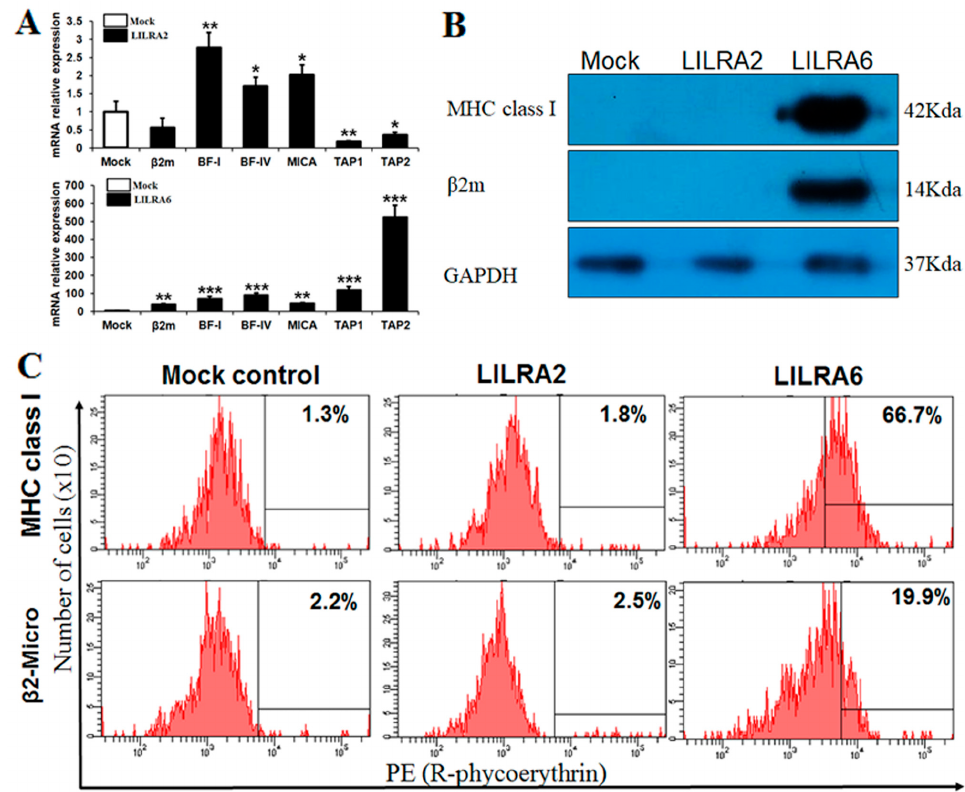
Figure 3. Chicken LILRA2 and LILRA6 binding with MHC class I and β 2m. ( A ) qRT-PCR for MHC class I family and related genes in LILRA2 and LILRA6 transfected HD11 cells; ( B ) Western blot for LILRA2 and LILRA6 transfected HD11 cells immunoprecipitated with the MHC class I, β 2m mAb, GAPDH antibody and then separated by SDS-PAGE and immunoblotted with secondary antibody; ( C ) FACS analysis of LILRA2 and LILRA6 binding with MHC class I and β 2m mAb in HD11 cells. Data are presented as the mean ± SEM of three independent experiments: * p < 0.05, ** p < 0.01 and *** p < 0.001.